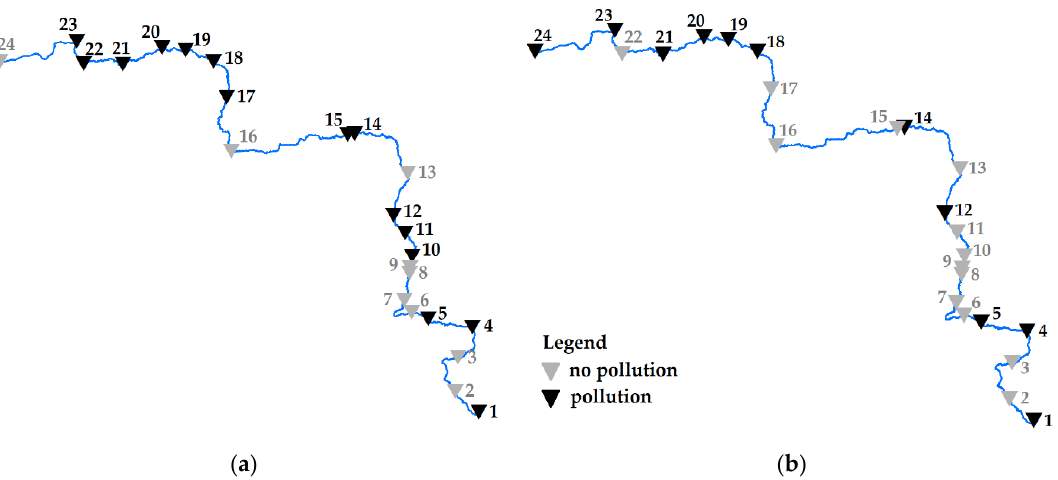
Figure 7. Classes of Pollution Load Index (PLI) in bottom sediments of the Warta River in 2016 ( a ) and 2017 ( b ). A similar picture of contamination of the Warta River bottom sediments with heavy metals emerges from the analysis of MPI values, pointing generally to a reduced level of contamination in 2017. The mean value of MPI in 2016 was 10.7 higher than that obtained in 2017. According to MPI analysis, in 2017 (MPI > 15) the highest contamination was noted at stations 1, 4, 18, 19, and 20. In 2016, the MPI values were higher than 15 at 11 of the 24 stations: 1, 4, 10, 12, 14, 15, 17, 19, 20, 21, 22, and 23 (Figure 8).